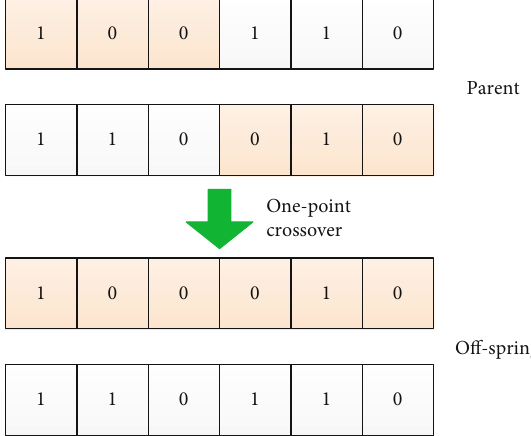
Figure 3: Schematic diagram of one-point crossover.